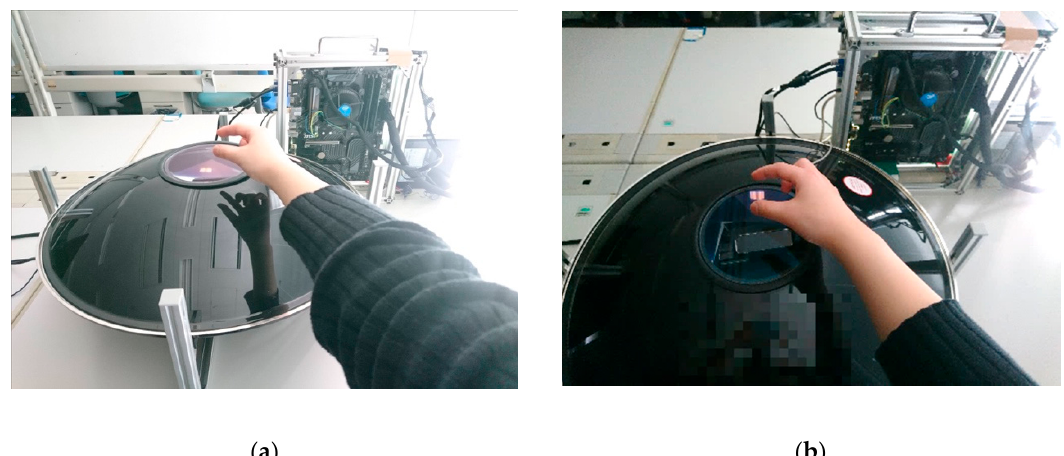
Figure 7. Testing Platform. ( a ) working scene -1, ( b ) working scene -2.